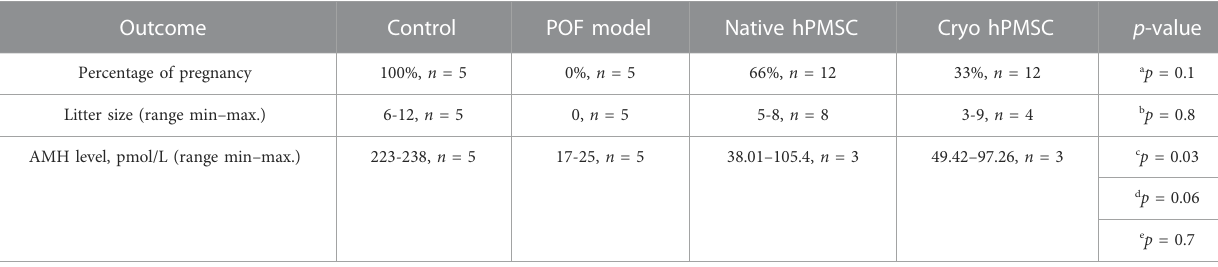
TABLE 2 Fertility outcomes and AMH level in the POF mouse model.